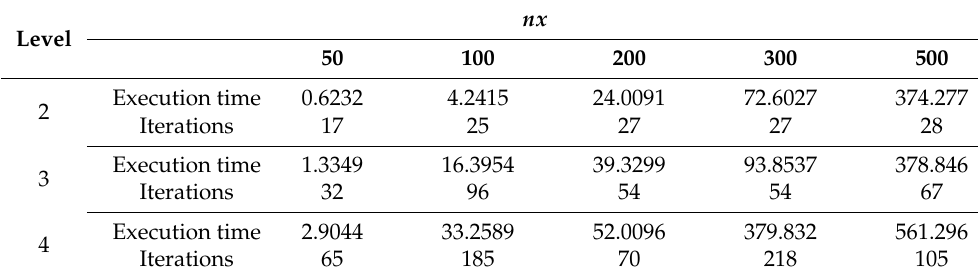
Table 3. Convergence behavior and performance of V cycle of AGAMG in combination with deflation technique and MGenFAspI with droptol = 0 and l fill = 1 for 2D Poisson model problem.